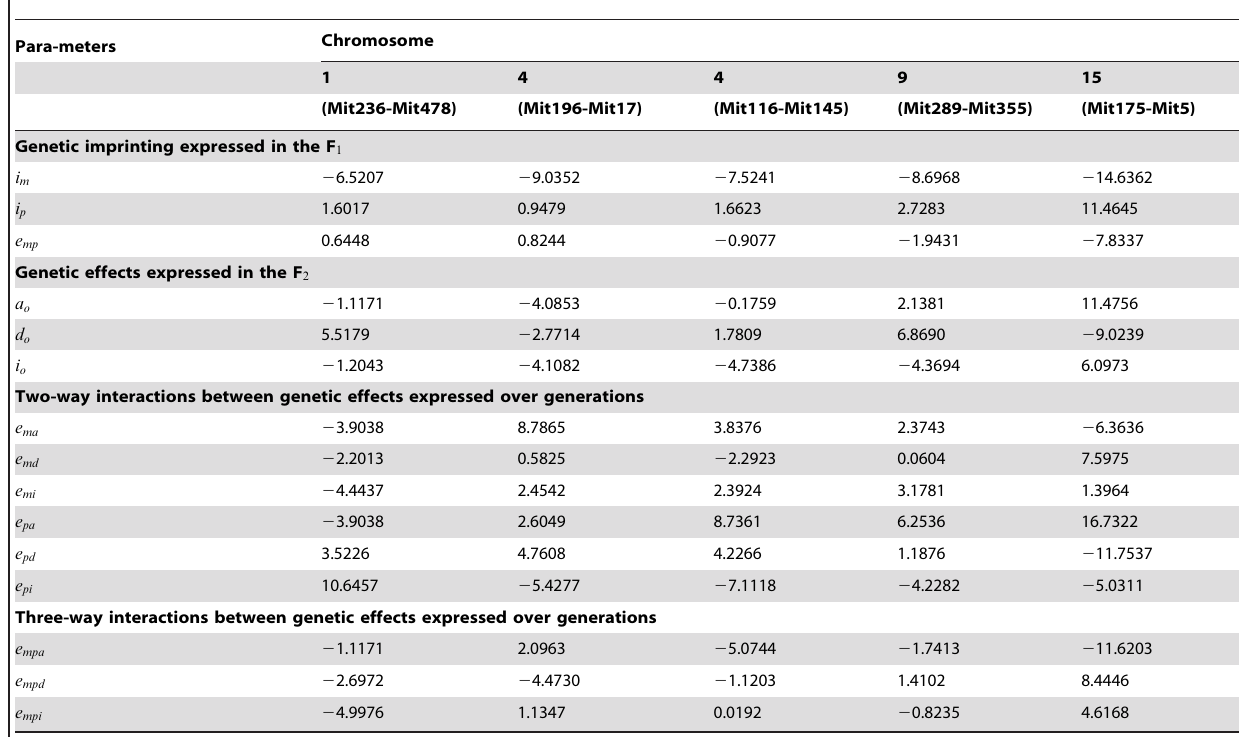
Table 2. Maximum likelihood estimates of genetic effect parameters for each iQTL detected on different chromosomes.